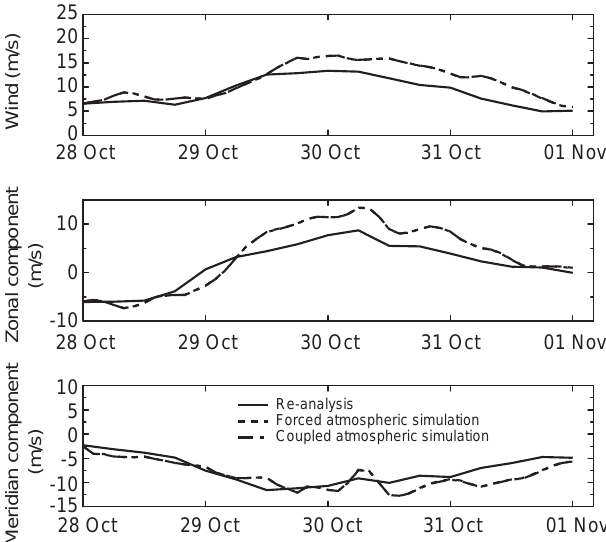
Fig. 4. From top to bottom: evolution of horizontal wind, zonal and meridional wind averaged on the simulation domain at the lowest Meso-NH vertical level (20 m). ARPEGE re-analysis ( solid line ), forced Meso-NH simulation ( dotted line ) and coupled Meso-NH simulation ( dashed line )